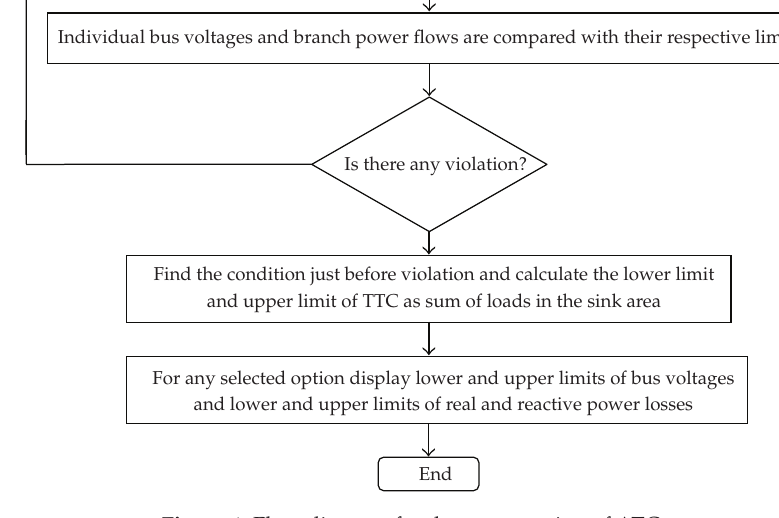
Figure 1: Flow diagram for the computation of